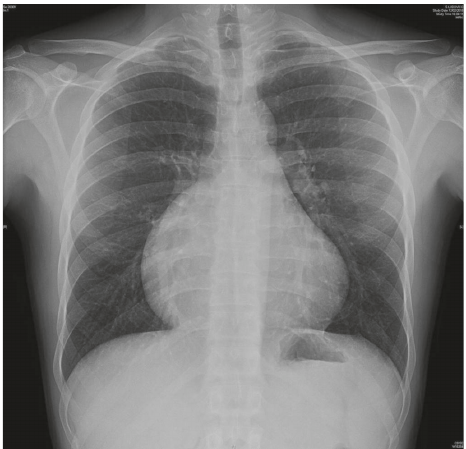
Figure 1: Chest radiograph showing cardiomegaly with right atrial